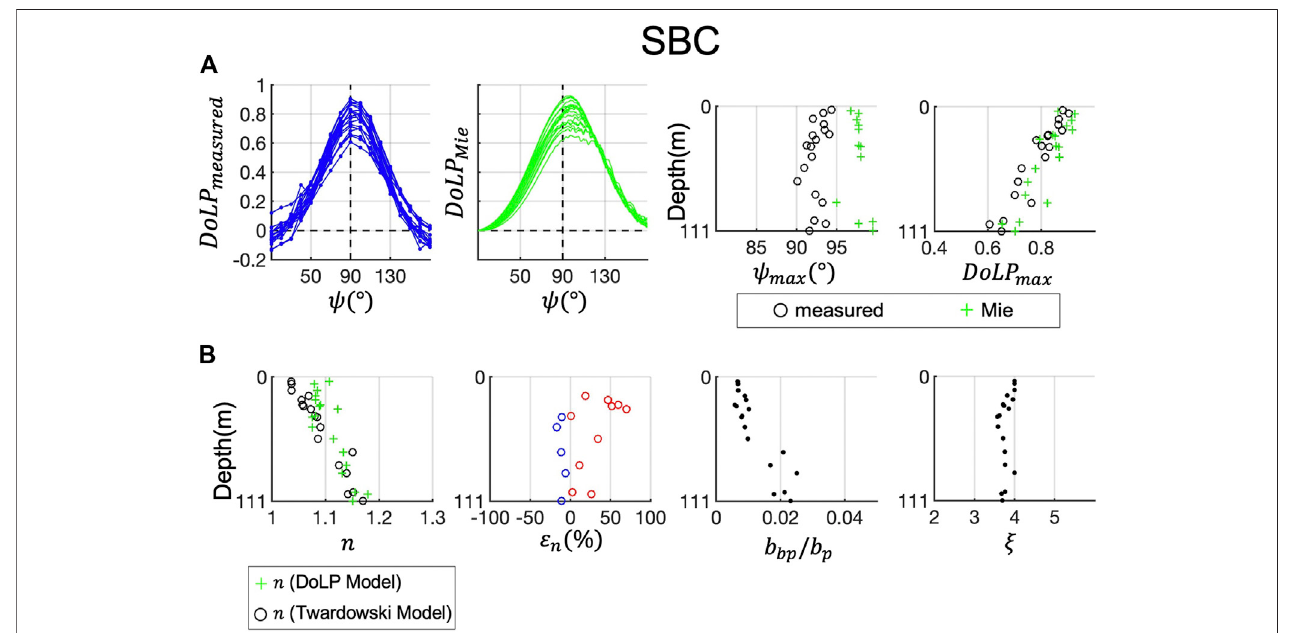
FIGURE 14 | Refractive index retrieval at fi eld site SBC (Santa Barbara Channel). Same as Figure 9 .